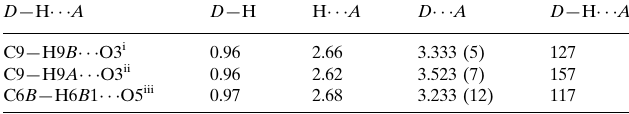
Hydrogen-bond geometry (A˚ , (cid:2)